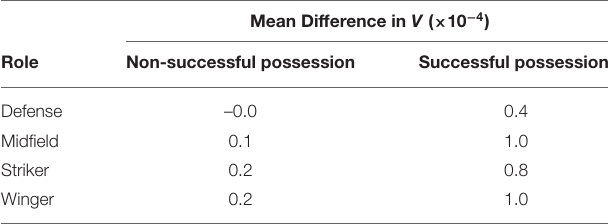
TABLE 5 | Average value function difference between simulated and observed trajectories categorized by approximate